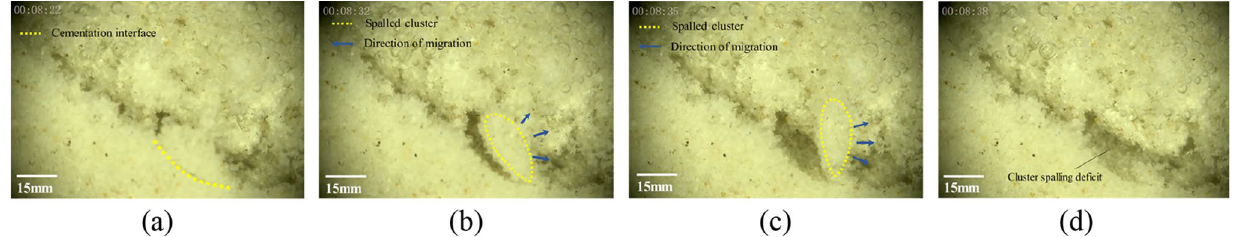
Fig. 20 Progress of the weakly-cemented interface detachment to form the microscopic deficit during the sanding simulation near the fluid outlet side of the No.11 sample. a It shows a weakly-cemented interface with detaching tendency; b the weakly-cemented interface